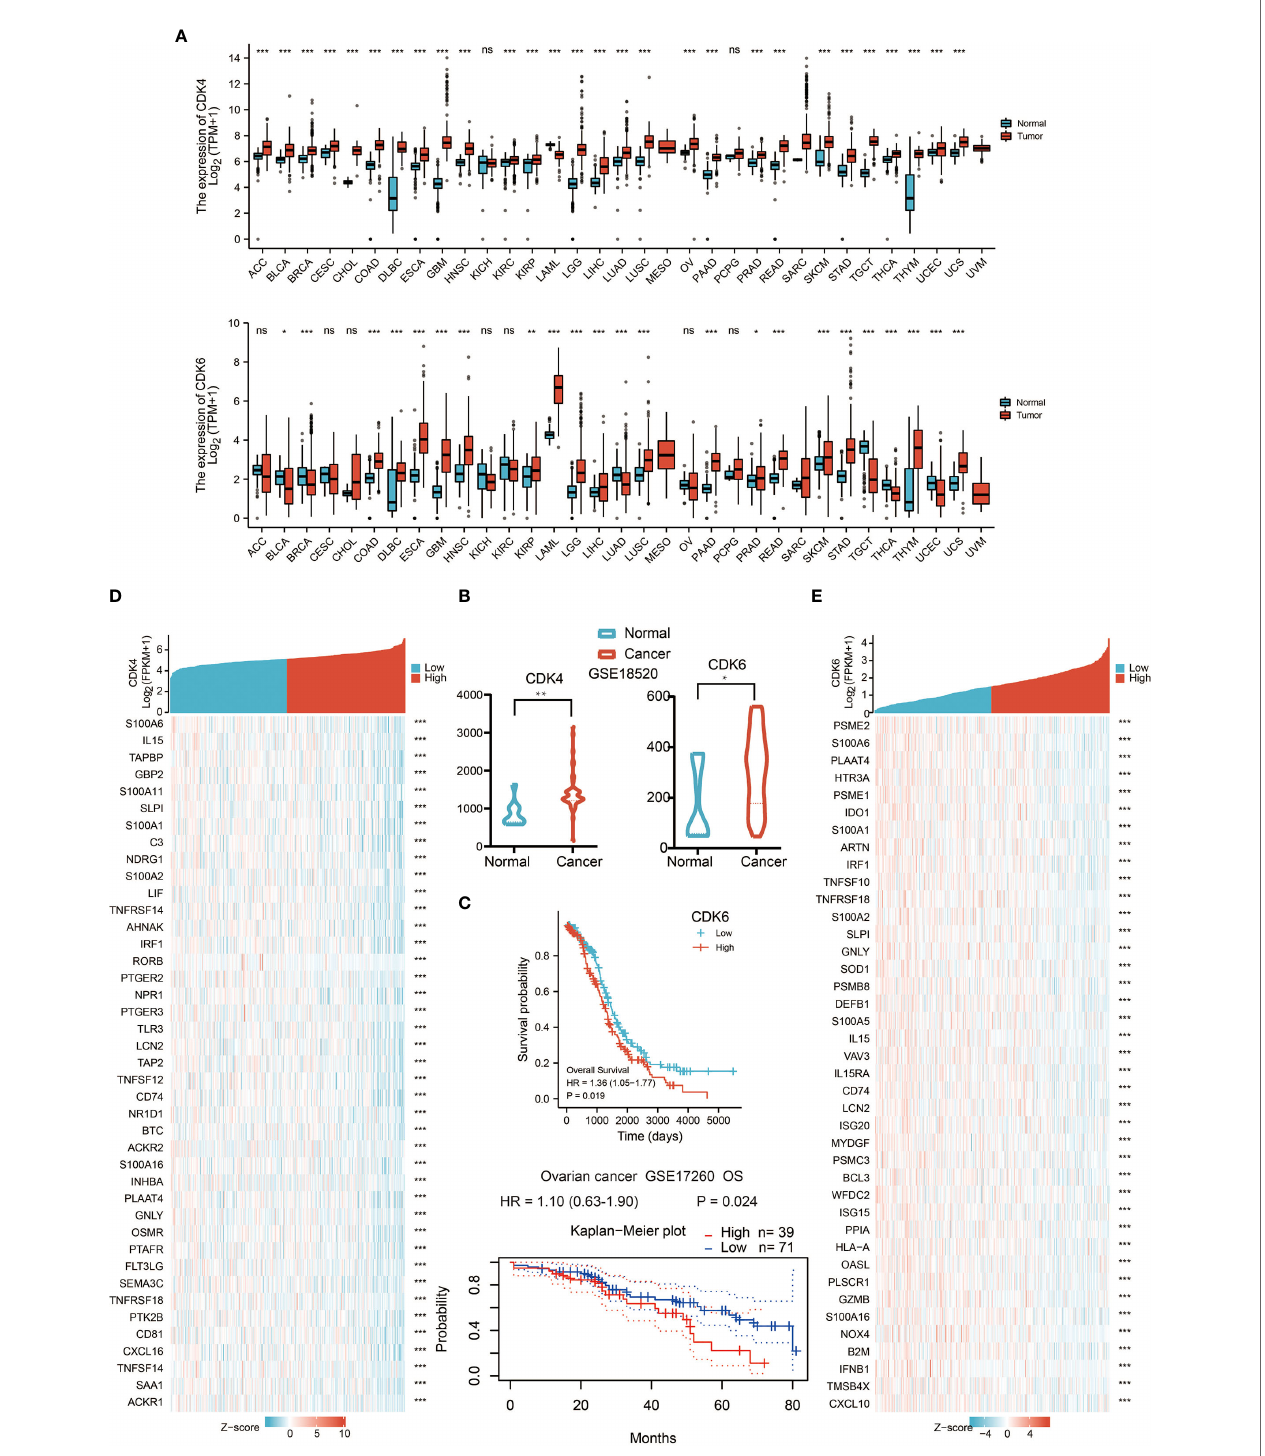
FIGURE 1 | The mRNA expression levels of CDK4/6 in different types of human cancers. (A) The expression of CDK4/6 in 33 types of human cancer based on cancer and normal data of the TCGA and GTEx cohorts. *p-value <0.05; **p-value <0.01; ***p-value <0.001; ns, nonsense. (B) Comparison of CDK4/6 gene expression between normal and tumor tissues in the GSE18520 dataset. *p-value <0.05; **p-value <0.01; ***p-value <0.001; ns, nonsense. (C) Kaplan – Meier analysis of the association between CDK4/6 expression and OS in OC. (D) Heat map showing the top 40 genes of CDK4 and immune correlation. (E) Heat map showing the top 40 genes of CDK6 and immune